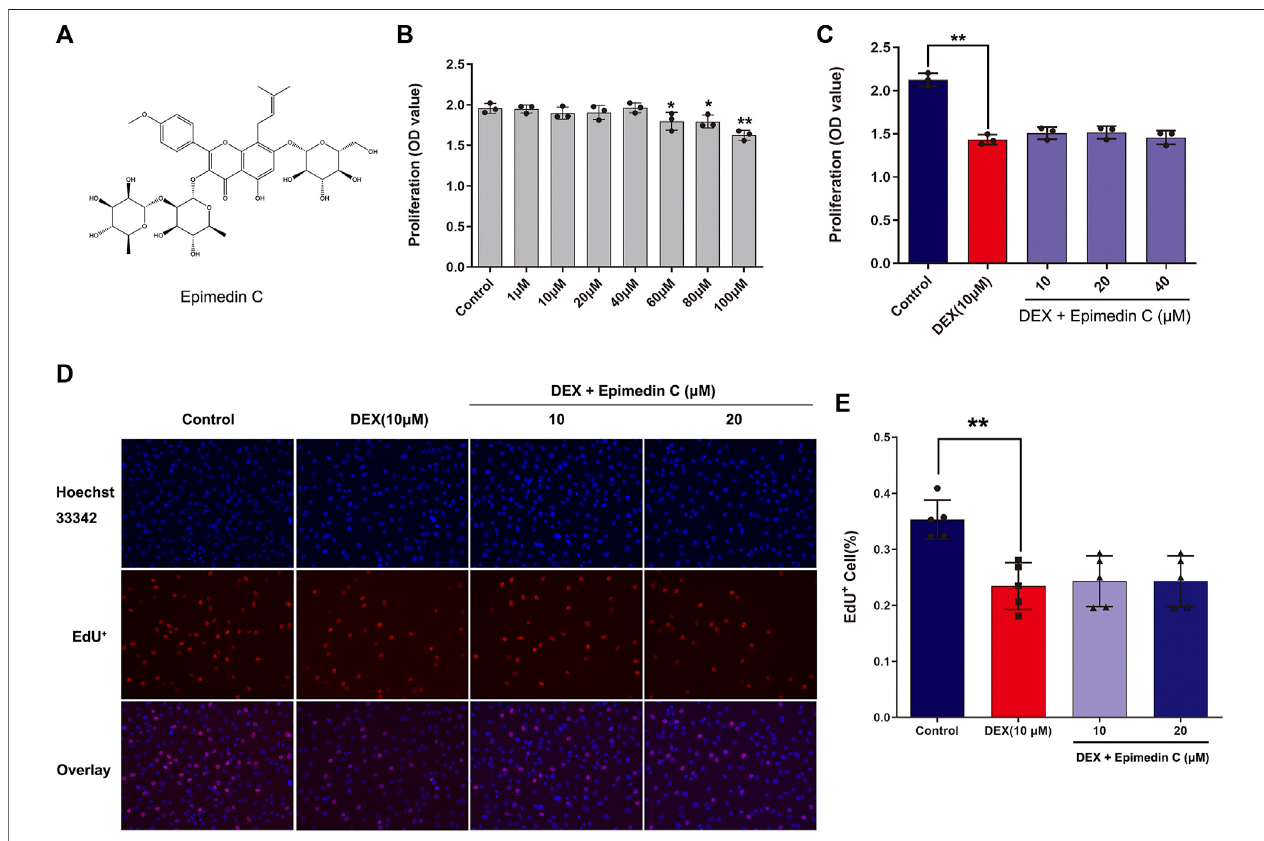
FIGURE 1 | Impacts of epimedin C on MC3T3-E1 cells viability and DEX-treated MC3T3-E1 cells. (A) The structural formula of epimedin (C) . (B) Epimedin C was used totreatthecellsfor72 hatvariousdoses; (C) TheMC3T3-E1cellsviabilitywasdeterminedutilizingCCK-8assayafter72 hofincubationwithepimedinCandDEX (10 μ M). (D,E) : Cells were treated for 24 h with epimedin C (10 and 20 μ M) and DEX. (10 μ M) and analyzed by EdU assay. *p < 0.05, **p < 0.01 vs.